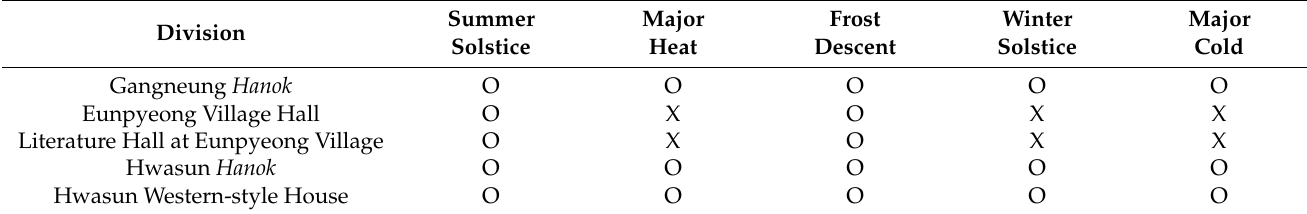
Table 4. Presence or absence of evaluation according to the